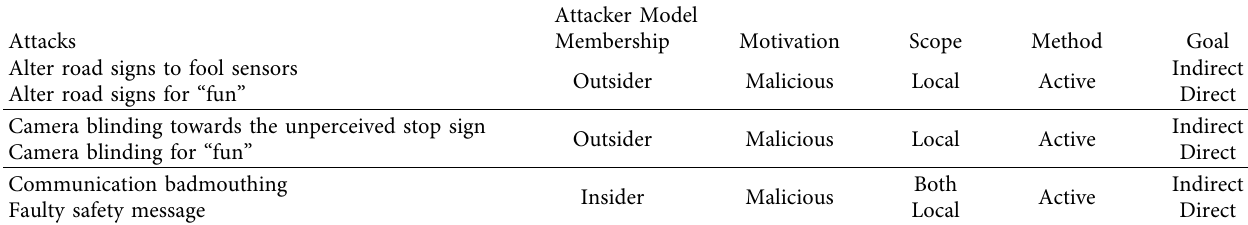
Table 2: Examples of similar attacks with a different